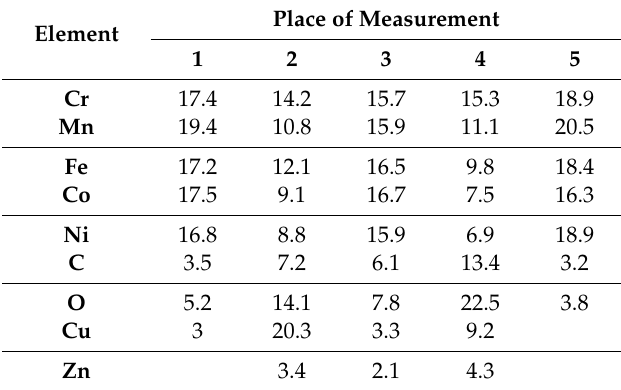
Table 6. Analysis of chemical composition in individual places according to Figure 6 in wt.